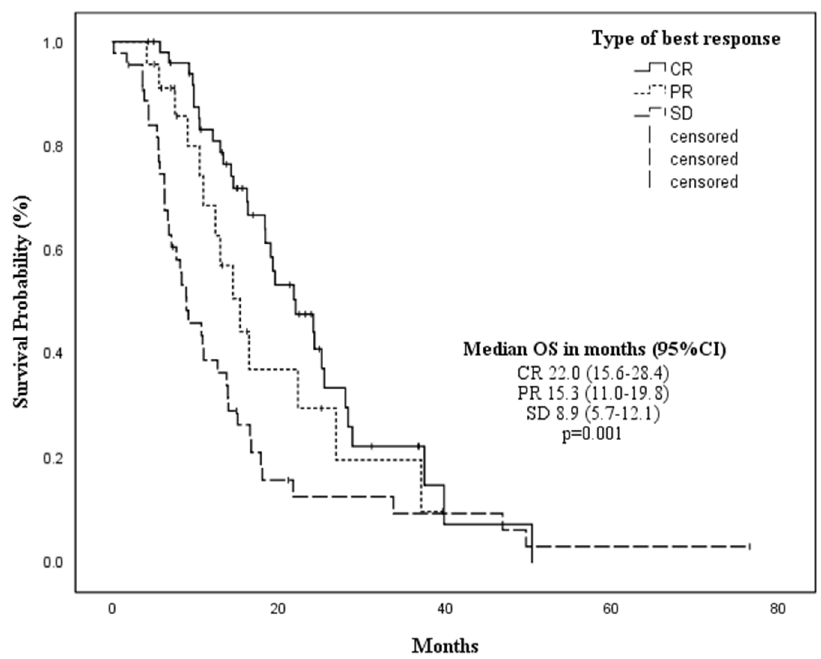
Figure 4. Median overall survival according to the type of response after four cycles of treatment. T he achievement of CR or PR as the best response during HMA treatment was significantly associated with better outcomes in terms of mOS ( p = 0.001). Indeed, no differences were seen comparing CR vs. PR ( p = 0.174) subgroups, while significant differences were observed comparing PR vs. SD ( p = 0.15) and CR vs. SD ( p < 0.001). Patients at adverse risk according to the ELN2017 classification had the worst survival (mOS 4.4 months vs. favorable risk 19.5 months, p < 0.001; vs. intermediate risk 10.7 months; p = 0.003).